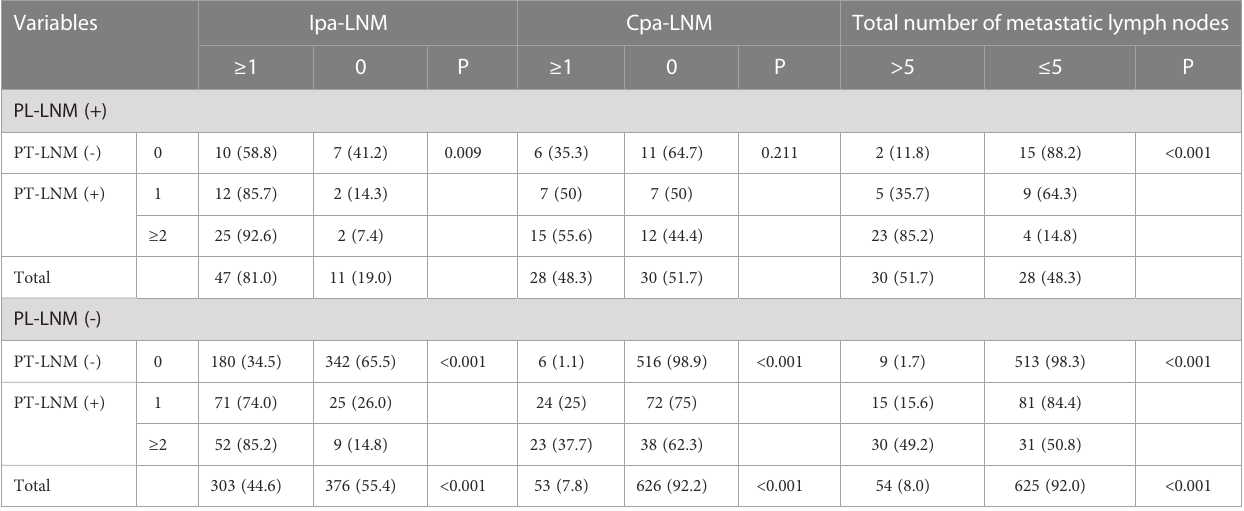
TABLE 6 The effect of different combinations of different statuses of prelaryngeal and pretracheal lymph nodes on paratracheal lymph node metastasis and more than 5 metastatic central lymph nodes.